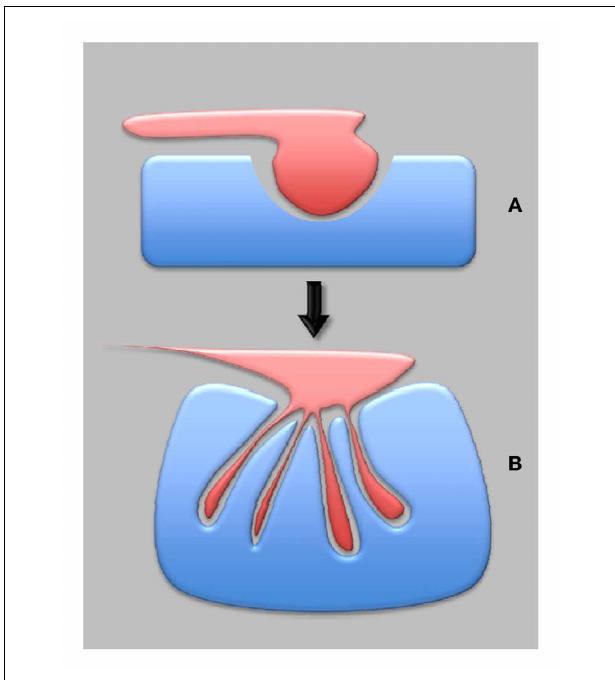
FIGURE 3 | Plant synapses in plant evolution—from pathogenic to symbiotic synapses. The most ancient are proposed to be pathogenic synapses (A) , which eventually developed into the symbiotic synapses (B) , provided that both partners negotiated well-balanced interactions.